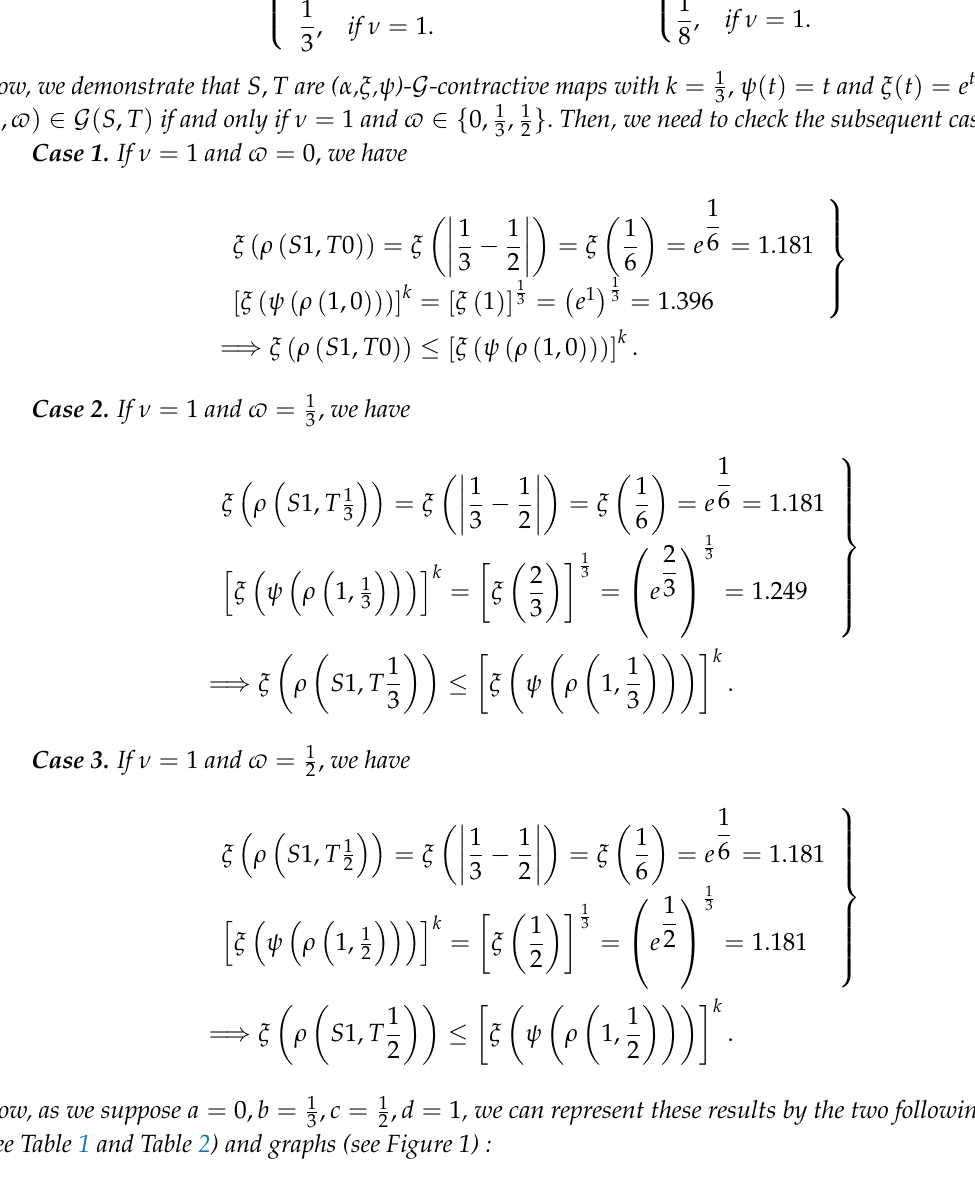
Table 1. A metric indicated by distances between